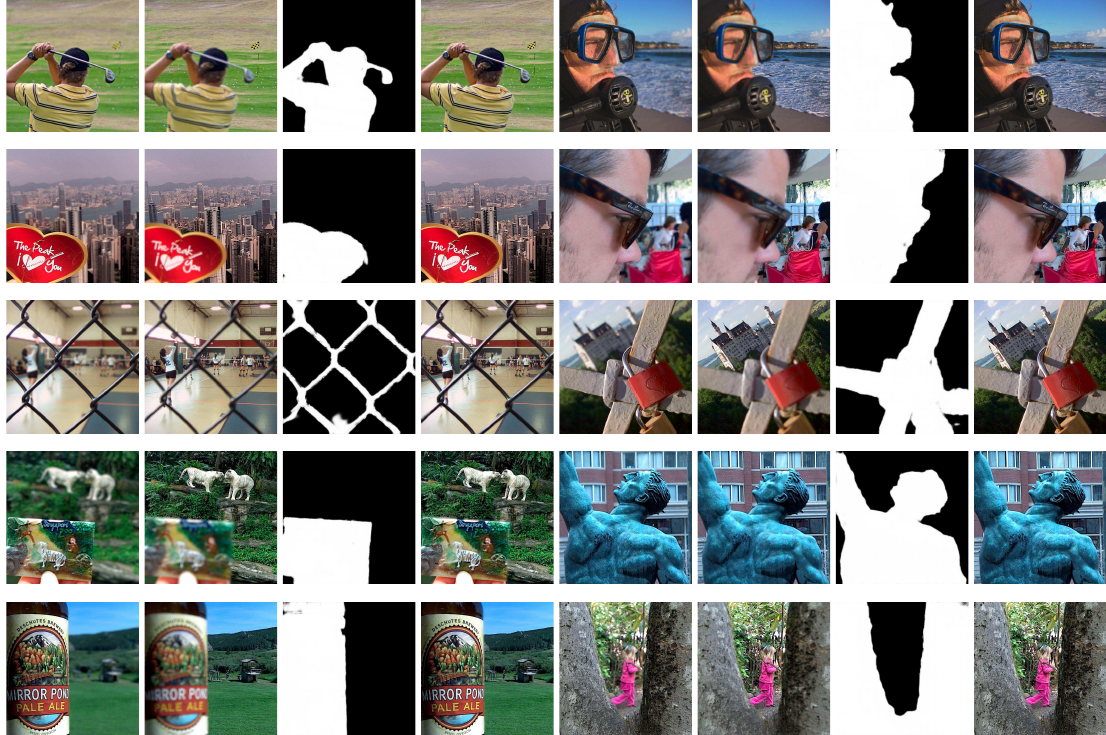
Figure 6. Visualization results of our method on Lytro dataset. Columns 1, 2, 5, 6 show the source multi-focus image pairs, columns 3, 7 show the decision map generated by the proposed network, and columns 4, 8 are the corresponding fusion results.